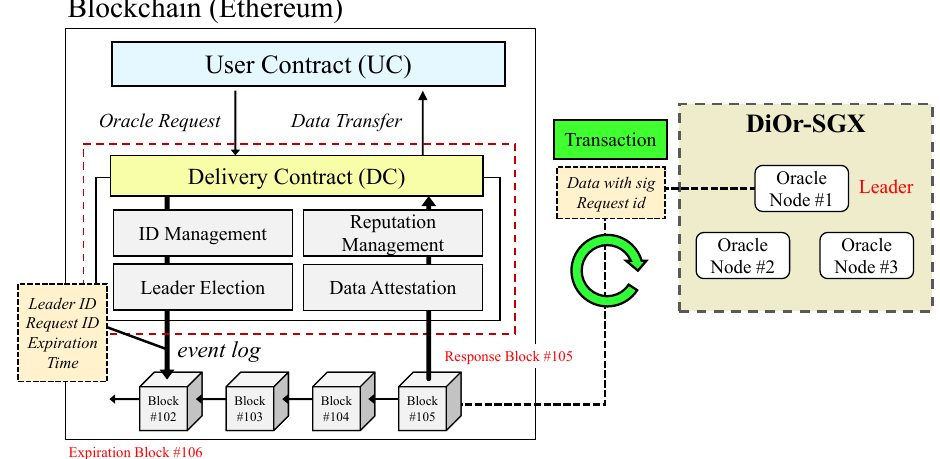
Figure 6. Delivery Contract